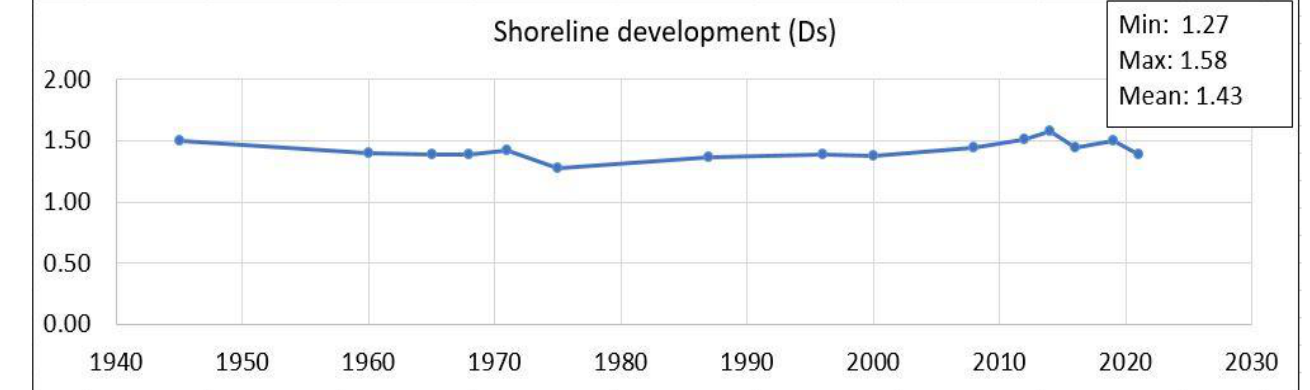
Figure 6. Lagoon’s orientation parameter fluctuations during the study period.